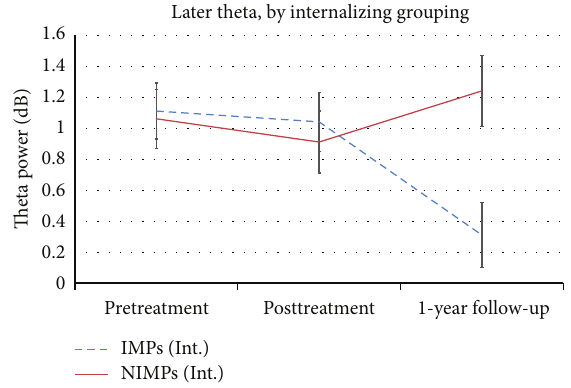
Figure 4: Line plot showing later theta power (in dB) for the inter- nalizing (Int.) grouping across all session time points broken down for improver status. NIMPs: nonimprovers; IMPs: